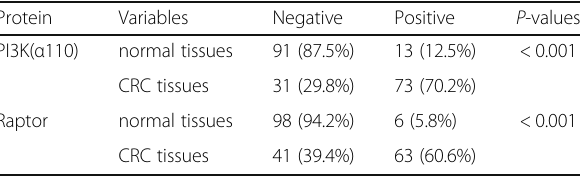
Table 1 Expression of PI3K( α 110) and Raptor in 104 CRC tissues and expression in 104 normal tissues Protein